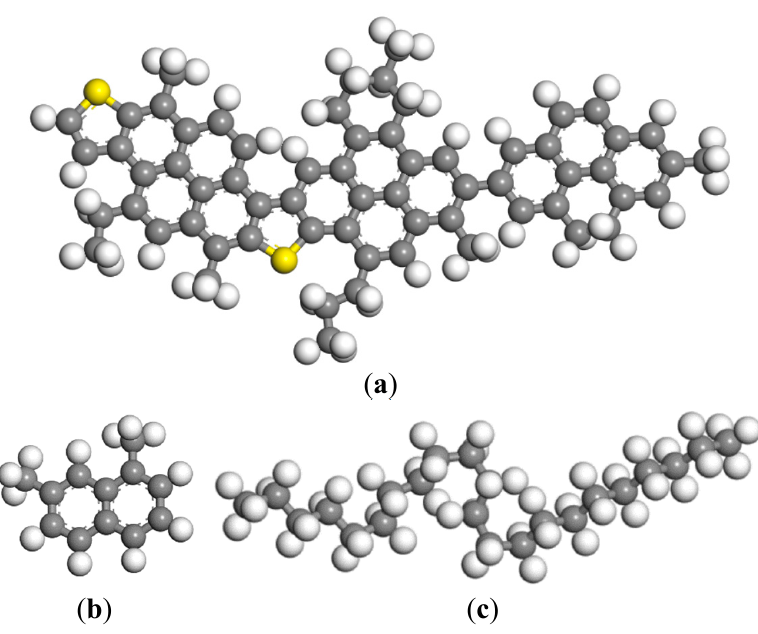
Figure 3. Molecular structures of ( a ) asphaltene; ( b ) resin (naphthene aromatics); ( c ) saturate (carbon atoms in gray, hydrogen atoms in white, and sulfur atoms in yellow).